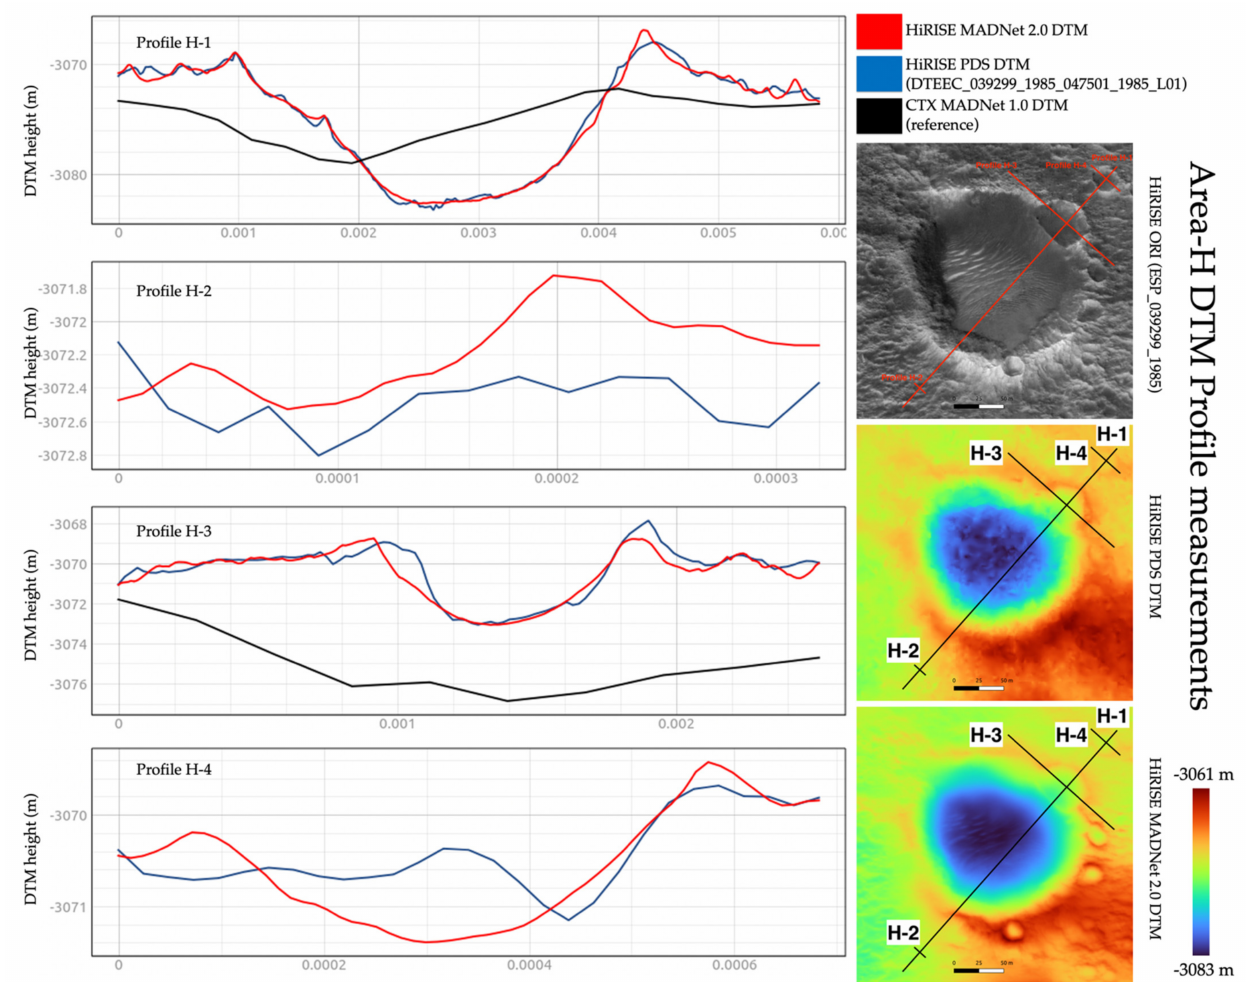
Figure 23. DTM profile measurements of the 1 m/pixel PDS HiRISE DTM, the 25 cm/pixel MADNet 2.0 DTM, and the 12 m/pixel MADNet 1.0 CTX DTMs (the reference DTM) for area-H (location is shown in Figure 10). N.B. all profile measurements begin from the labelled side of the profiles lines that are shown on the image and DTMs to the other end of the